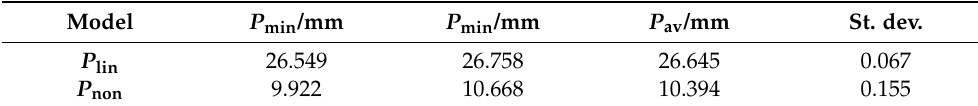
Table 3. Statistical results related to linear and nonlinear buckling loads (see Tables 2 and 4).